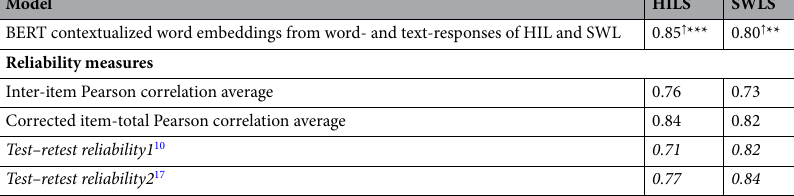
Table 1. Comparing Pearson Correlations based on All Responses Combined and Analyzed with Contextualized Word Embeddings to the Reliability of the Rating Scales. Italic values indiactes results from other articles/datasets. All correlations were significant at p < 0.001. N = 608. HIL = Harmony in life; SWL = Satisfaction with life; S = Scale. ↑ = significantly higher than Inter-item correlation average; *** = p < 0.001, ** = p < 0.001.